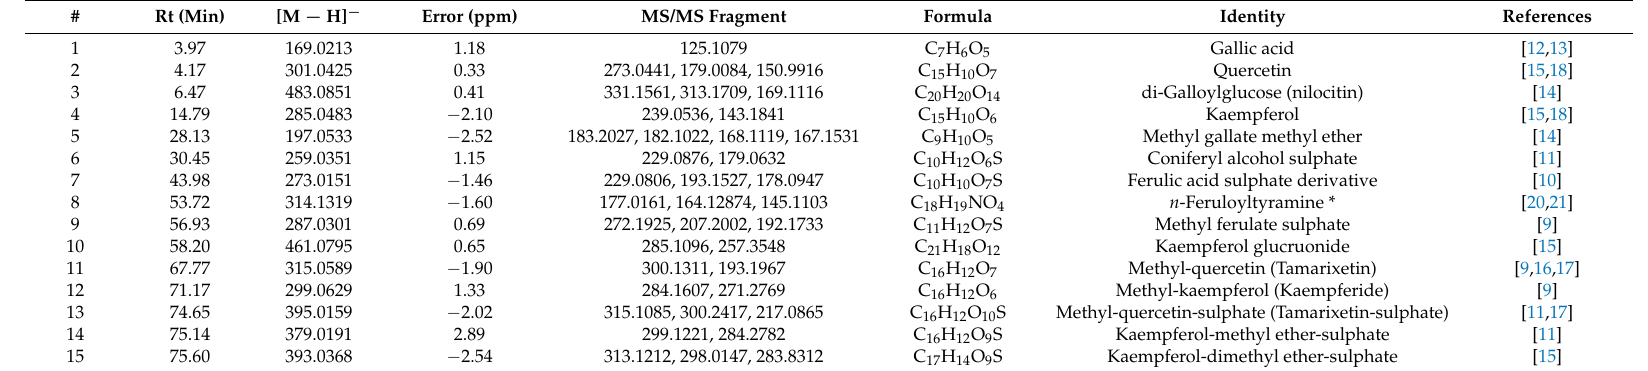
Table 2. Characterization of metabolites from STN by HPLC-MS/MS in negative ion